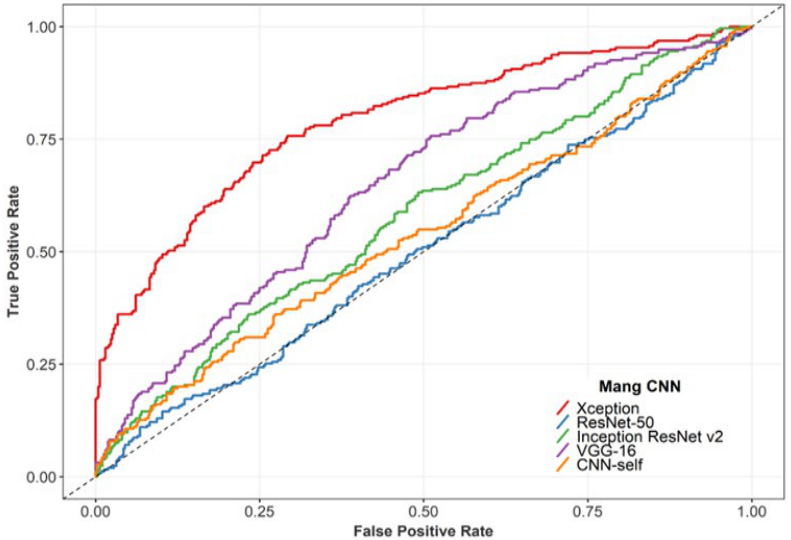
Figure 3. ROC curves of comparison of the classification performances.